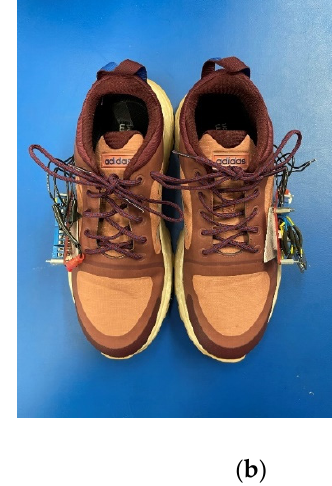
Figure 2. ( a ) men’s size 10.5 shoe with integrated insole pressure system and microcontroller shown. ( b ) women’s size 8.5 shoe with insole pressure system and microcontroller shown.